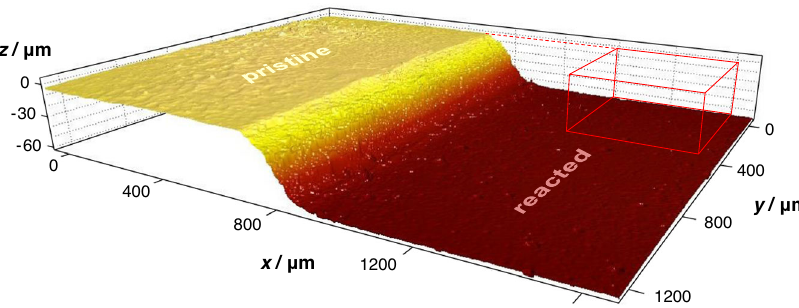
Fig. 1 3D VSI image of a partly reacted PET fi lm surface. The step pro fi le shows the surface retreat after a reaction time of 8 h relative to a protected area (left). For specifying the rate of degradation over time, the volume loss on a unit area (red cuboid) near the protected region was determined.